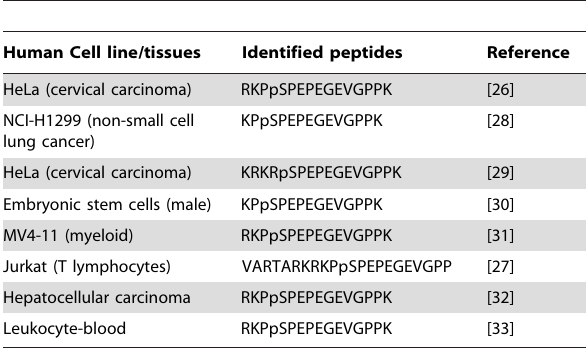
Table 1. Serine 360 of IRF2BP2 is phosphorylated in multiple human cell types.